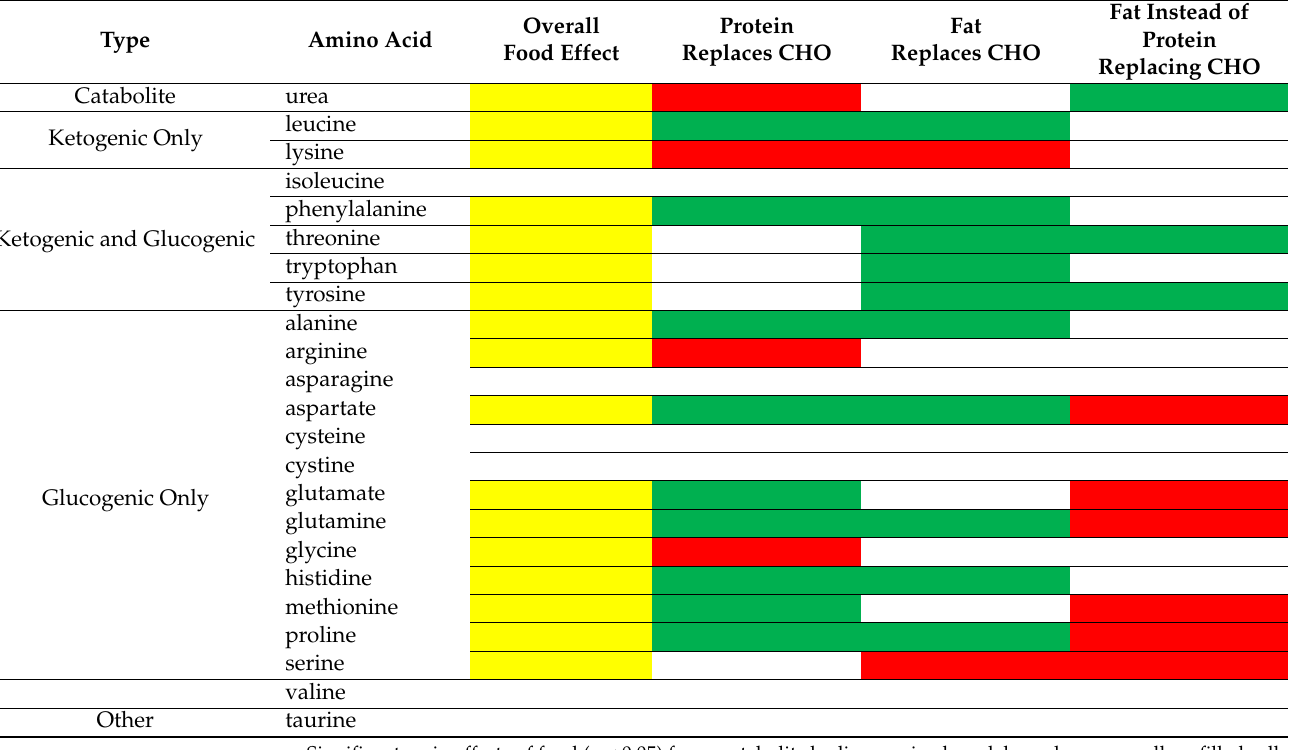
Table 4. Effects of foods on serum amino acids.